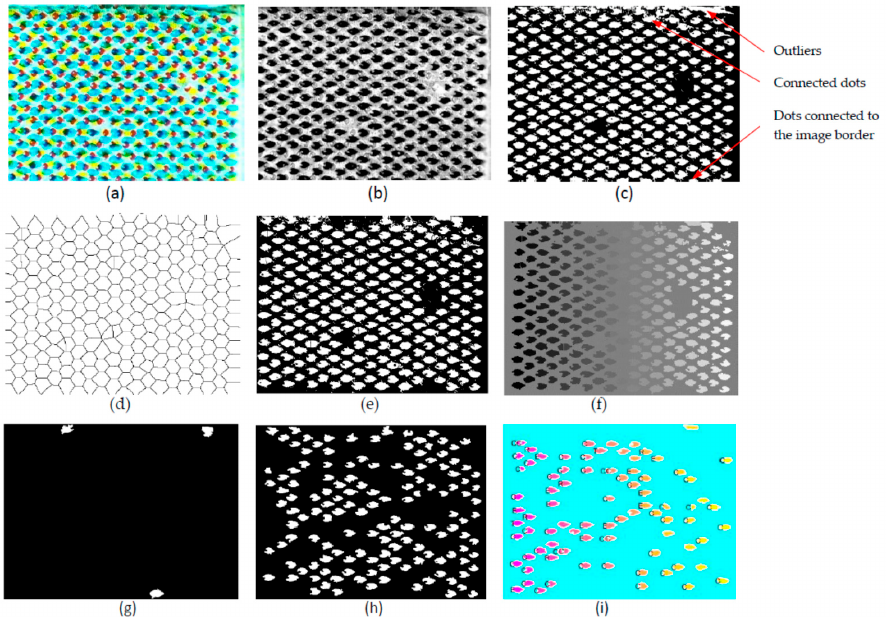
Figure 7. Illustration of the results obtained step by step. In this example, cyan dots are extracted, measured and analyzed. (a) CMY image, (b) Step 1: extraction of C channel, (c) Step 2: binarization, (d) Step 3.5: isosurface of distance transform, (e) Steps 3.1 to 3.4: removal of noise and irrelevant areas. (f) Step 4: labelling of regions of interest, (g) Step 5: removal of outliers, (h) Step 7: extraction of dots with concavity ( ∈ ID1/ID2/ID3) or an irregular shape ( ∈ ID4) defined by a solidity upper than 0.75, (i) extraction of dots with a convex shape ( ∈ ID5) with a circular equivalent shape, or an elliptic equivalent shape, or another pattern shape.